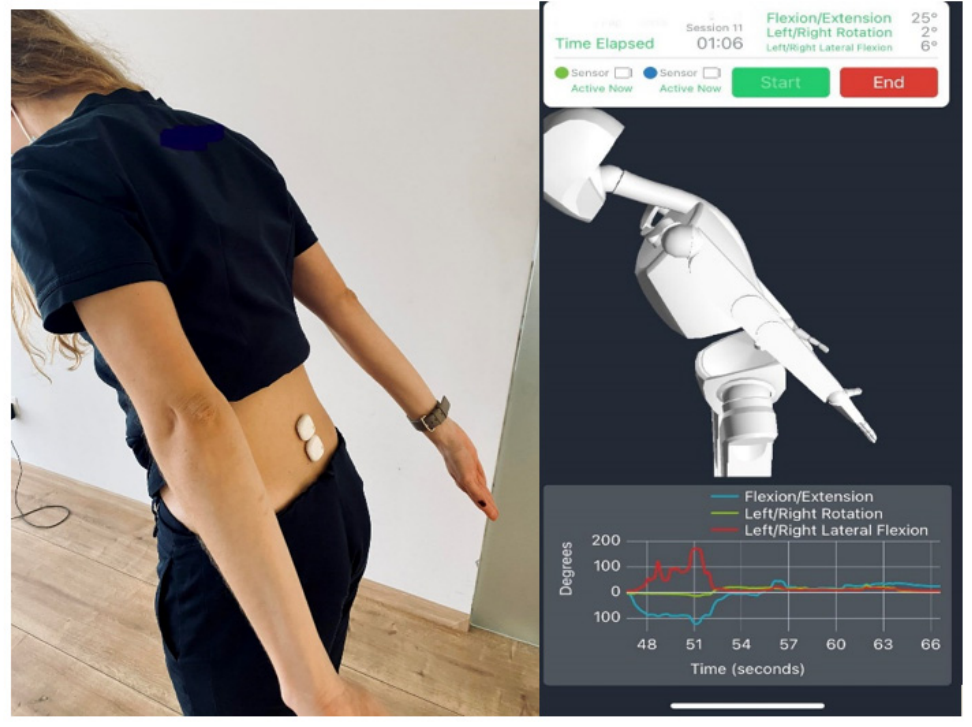
Figure 1. Wearable sensors application at the lumbar spine. Software reproduction–kinematic data recording.